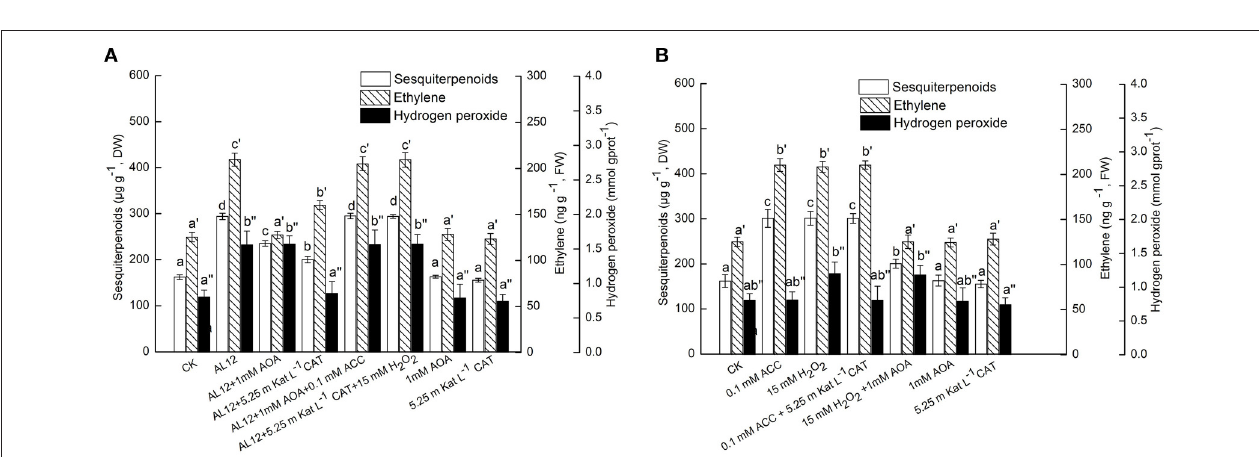
FIGURE 4 | (A) Interaction between ethylene and H 2 O 2 signaling pathways for endophytic fungus AL12-induced sesquiterpenoids accumulation in Atractylodes lancea plantlets. Thirty-day-old plantlets treated with 5-mm AL12 mycelial disks, 1 mM AOA, 5.25 m Kat L − 1 CAT, 0.1 mM ACC and 15 mM H 2 O 2 were harvested after 15 days to determine the sesquiterpenoids, ethylene and H 2 O 2 contents. Inhibitors were added 1 day prior to endophytic fungus AL12 inoculation or exogenous signal donor application. Controls were established using equal sized potato dextrose agar disks. Values are the means of three independent experiments ± SD. Bars with different lowercase letters (e.g., a, b, c; a ′ , b ′ , c ′ ; a ′′ , b ′′ , c ′′ ) are significantly different ( P < 0.05). (B) Dependence of H 2 O 2 -induced sesquiterpenoids accumulation on ethylene in Atractylodes lancea plantlets. Thirty-day-old plantlets treated with 0.1 mM ACC, 15 mM H 2 O 2 , 1 mM AOA, and 5.25 m Kat L − 1 CAT were harvested 15 days later to determine the sesquiterpenoids, ethylene and H 2 O 2 contents. Inhibitors were added 1 day prior to exogenous signal donor application. Controls were established using equal volume of double distilled water. Values are the means of three independent experiments ± SD. Bars with different lowercase letters (e.g., a, b, c; a ′ , b ′ , c ′ ; a ′′ , b ′′ , c ′′ ) are significantly different ( P <